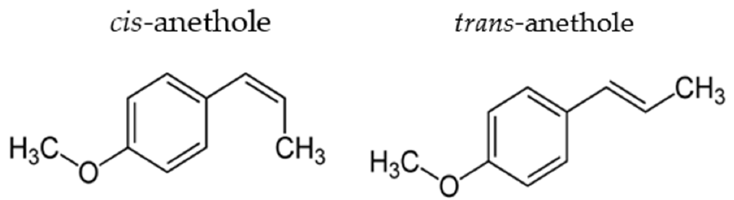
Figure 1. Chemical structural formula of cis ‐ and trans ‐ anethole.